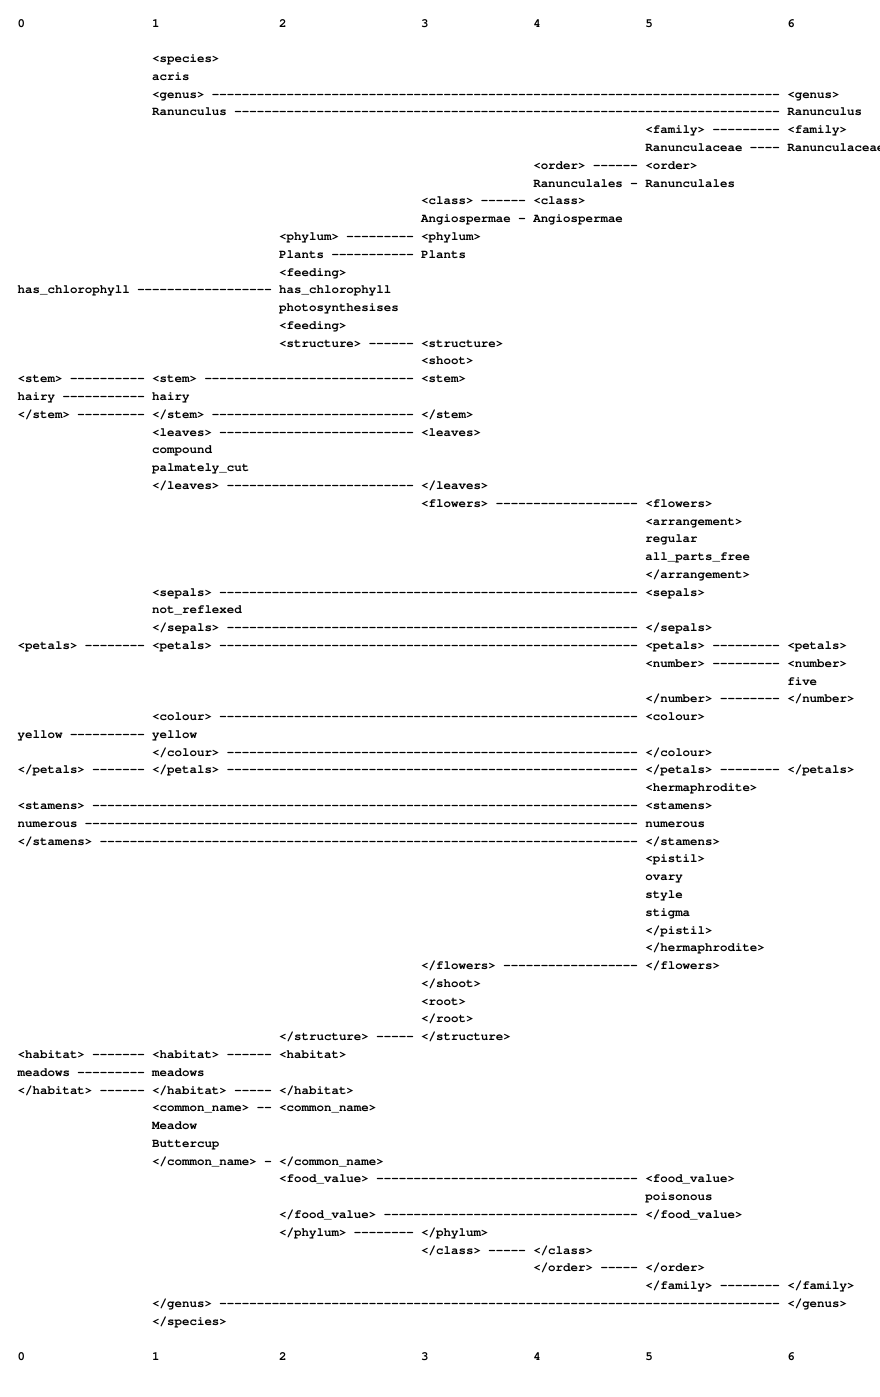
Figure 16. The best multiple alignment created by the SP model, with a set of New patterns (in column 0) that describe some features of an unknown plant and a set of Old patterns, including those shown in columns 1 to 6, that describe different categories of plant, with their parts and sub-parts and other